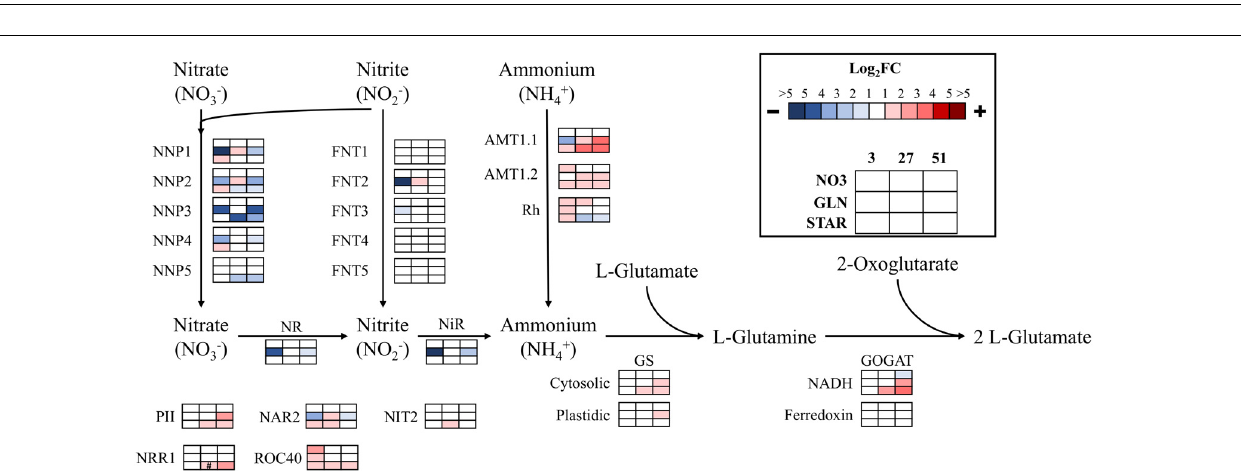
FIGURE 2 | Euler diagrams of differentially expressed (DE) genes by nitrogen source. Each area-proportional Euler diagram represents differential expression between nitrogen conditions at each time point (3, 27, and 51 h) and are scaled to the 51 h comparison. The total number of DE genes in each comparison is displayed under each label. The number of shared genes for each comparison is displayed within the overlap region between comparisons. The color scheme represents the same nitrogen source comparison made among each time point. The 27 h diagram does not have all numbers displayed due to the small amount of DE genes for the GLN vs. NO3 condition. Full numerical output is in Supplementary Table S1 . Euler diagrams created using euler APE (Micallef and Rodgers, 2014). Abbreviations: GLN, Glutamine; NO3, nitrate; STAR, nitrogen starvation.